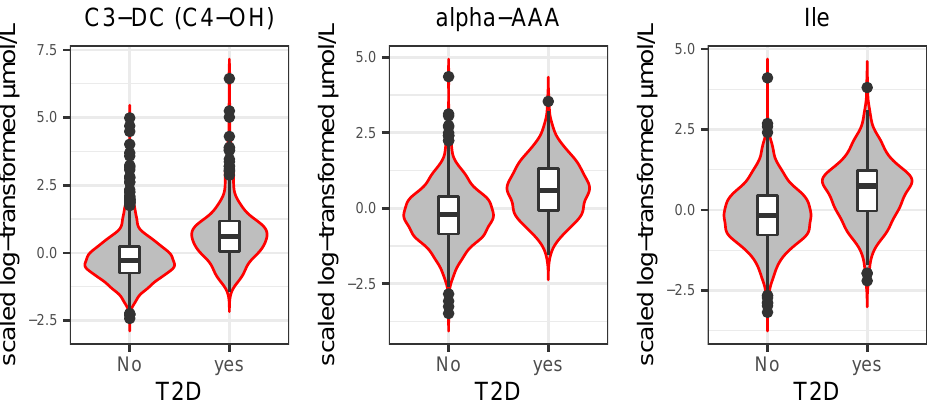
Figure 4. Violin-box plots show the distribution of three significant metabolites stratified by diabetic status. The box contains 50% of the observations. The middle line stands for median dividing the box into two areas. The 25th and 75th percentile of the distribution are represented by upper and lower